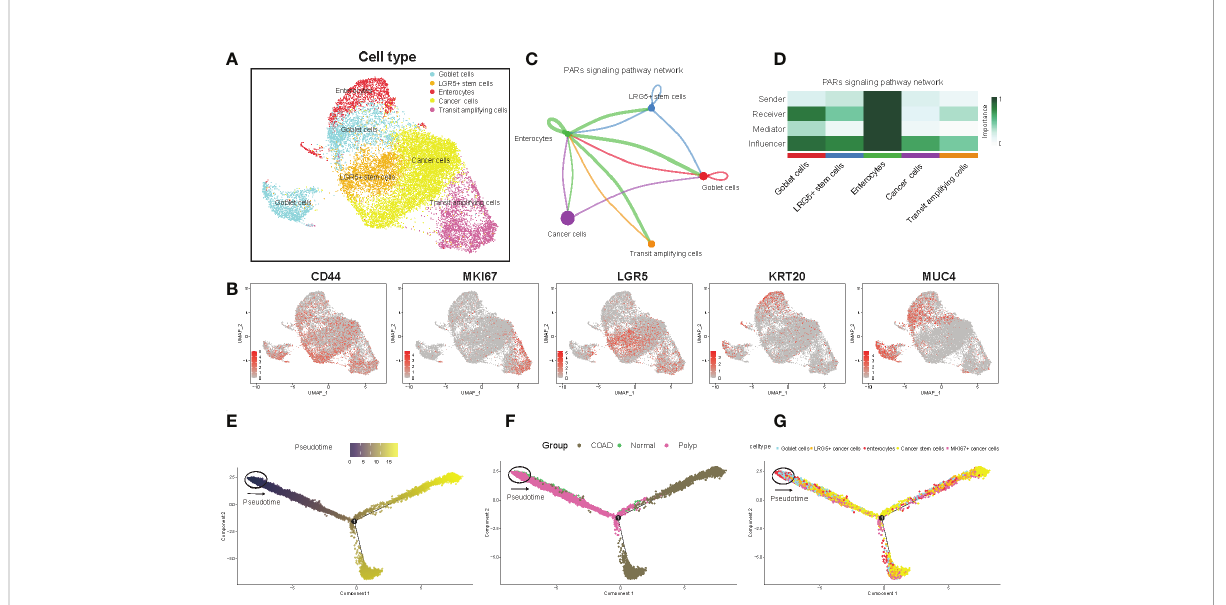
FIGURE 2 Epithelial cell clusters, cell-cell communication, and pseudotime analysis. (A) The UMAP plot of epithelial cells is color-coded by their associated cluster or cell classi fi cation. (B) Each UMAP plot shows the expression of a known cell-type speci fi c marker gene, as indicated at the top. (C) The cell-cell communication network (D) Heatmap shows the correlation between different cell types. (E – G) Trajectory reconstruction (E) of all single cells from different samples (F) and cell types (G) is